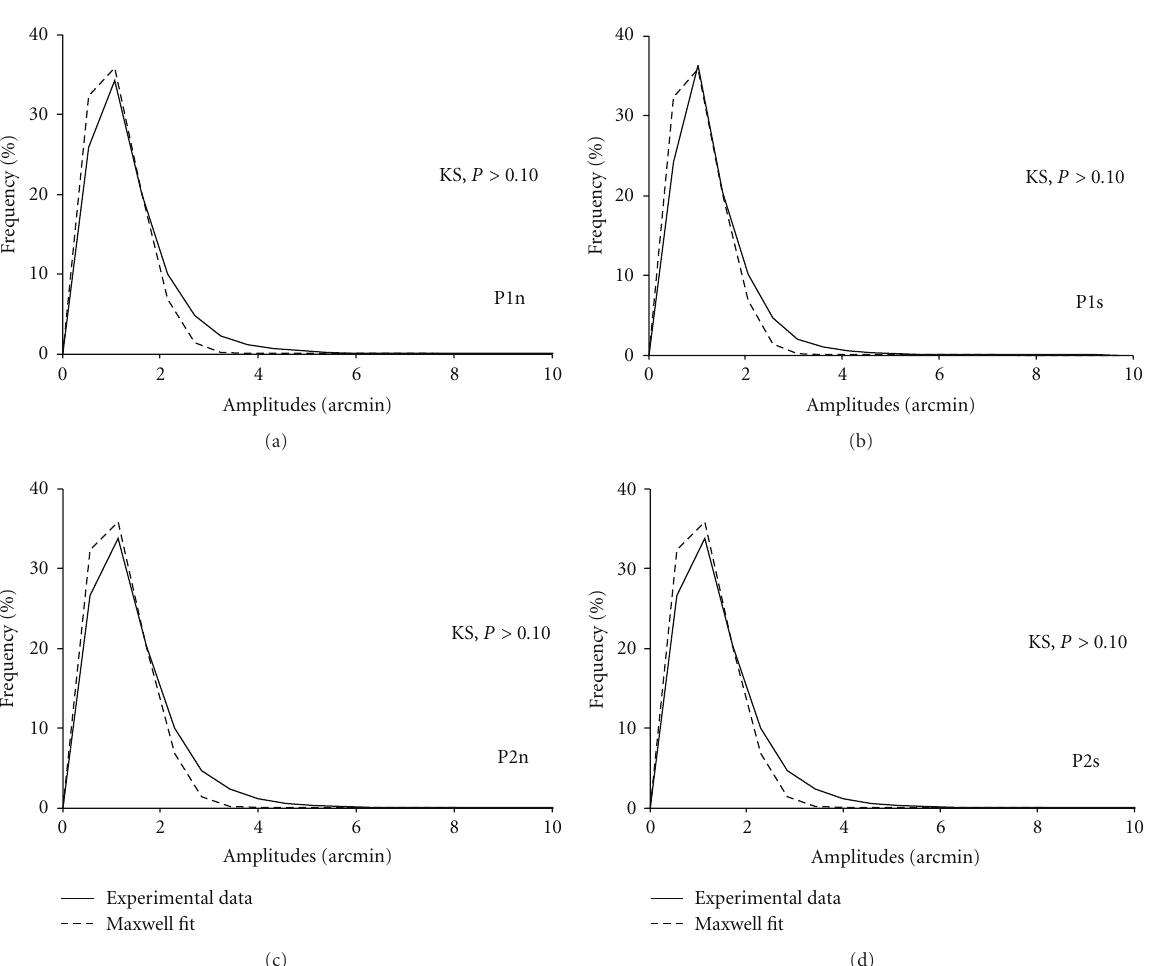
Figure 4: Probability density function (PDF) of eye-movement amplitudes for each participant (P1 and P2) and for each scene condition (n for normal, s for scrambled). Other notations as in Figure